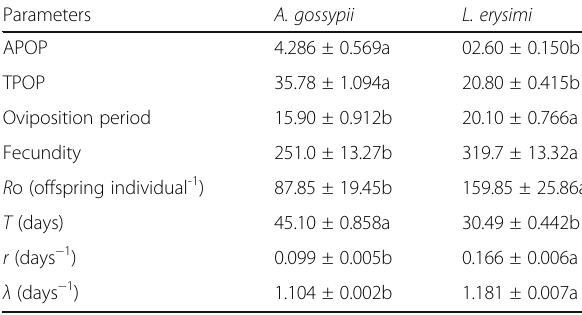
Table 2 Comparison of reproductive and life table